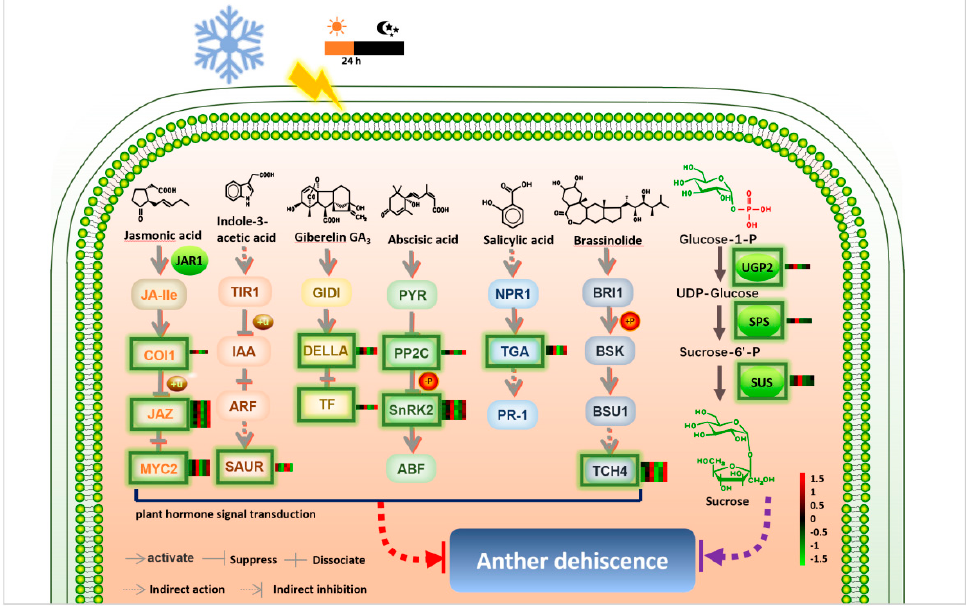
Figure 6. A hypothetical model of hormones and sucrose regulating anther dehiscence in